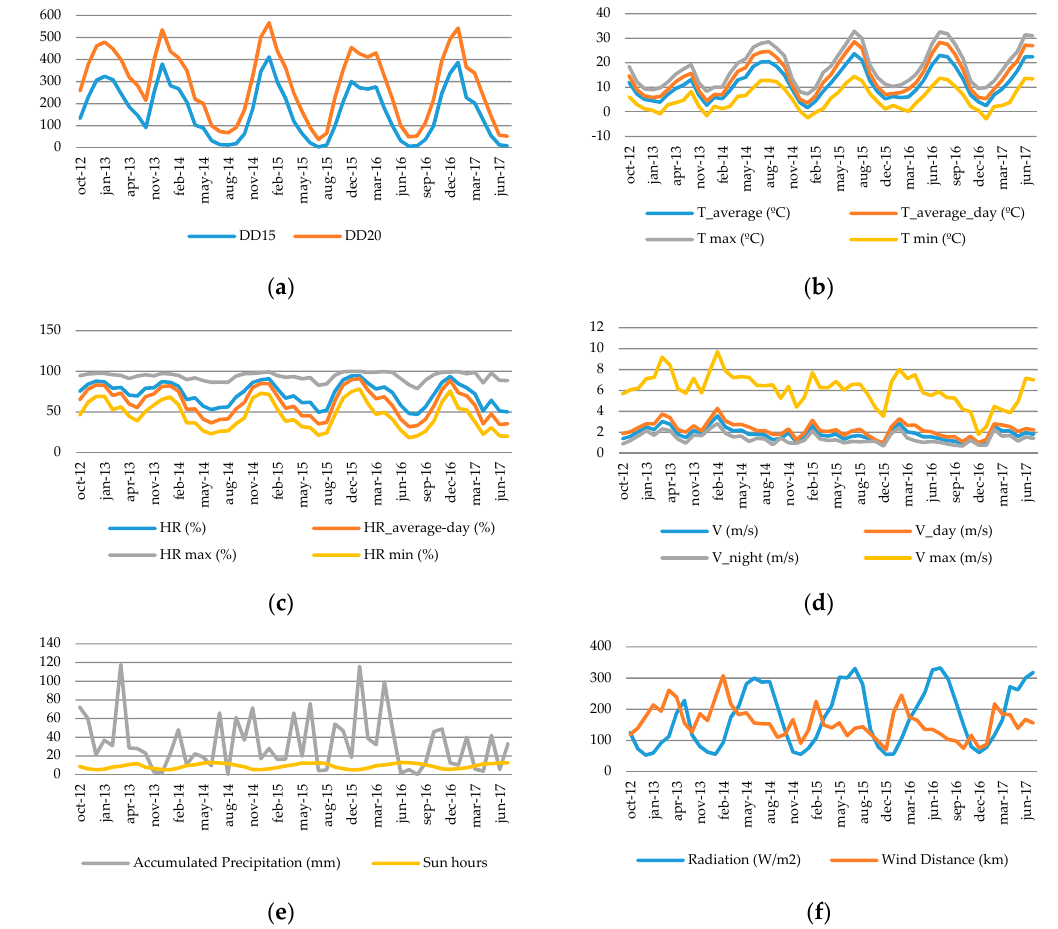
Figure 3. Climatological data used by the study variables. ( a ) DD, ( b ) Temperature, ( c ) Humidity, ( d ) Velocity, ( e ) Precipitation and sun hours, ( f ) Radiation and wind distance.